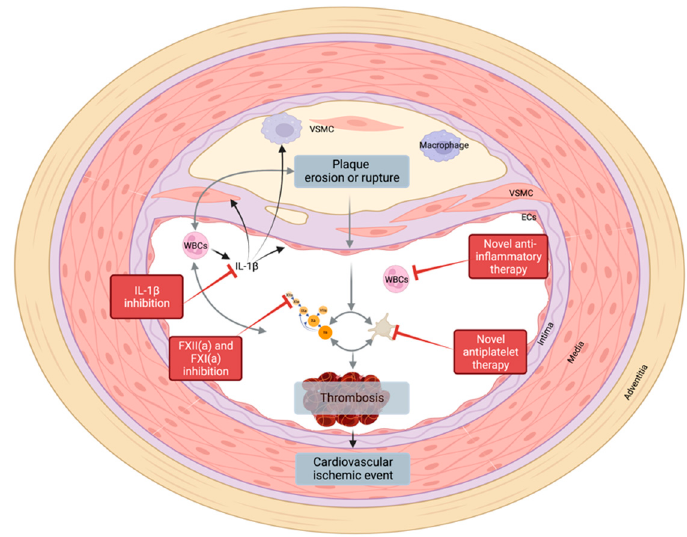
Figure 4. Indication of the main therapeutic targets providing possible approaches to combat atherosclerosis. Created with Biorender.com (accessed on 10 October